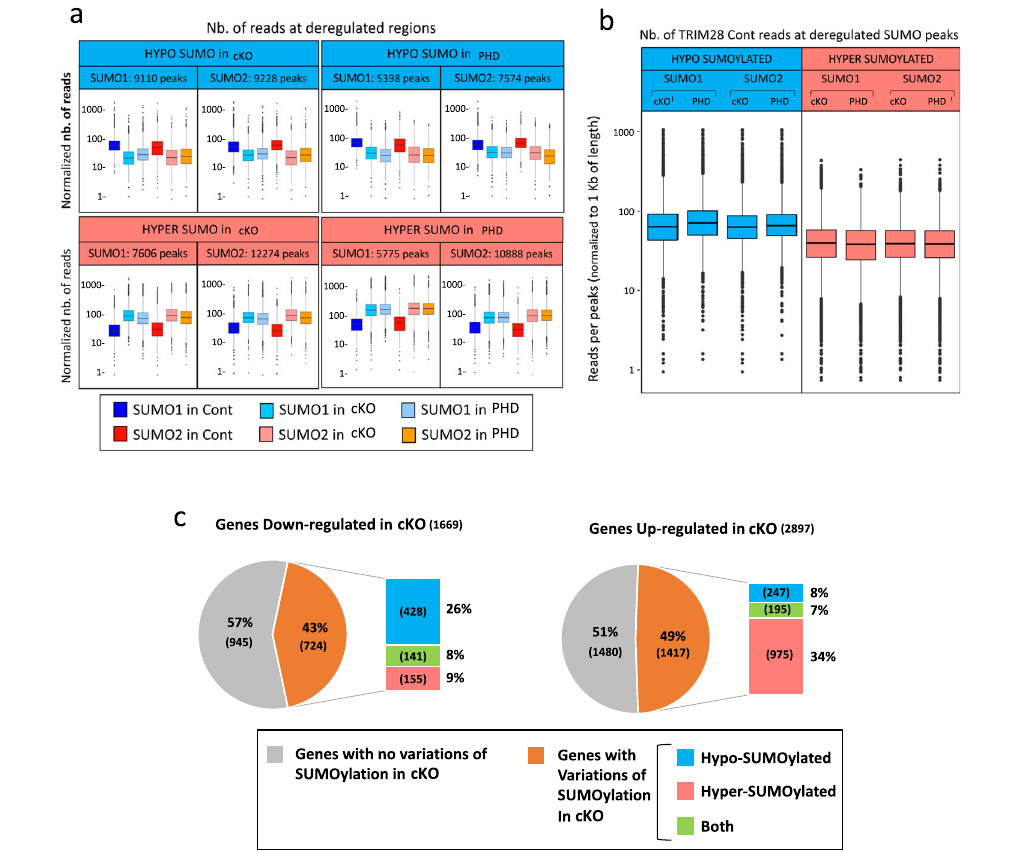
Fig. 5 | Genome-wide SUMOylation changes in Trim28 cKO and Trim28 Phd/cKO ovaries. a Normalised quanti fi cation of SUMO1 and SUMO2 ChIP-seq reads from control (Cont), Trim28 cKO (cKO) and Trim28 Phd/cKO (PHD) ovaries mapped on deregulated regions: peaks signi fi cantly decreased (Log2 Fold-Change <1; hypo- SUMOylated; blue), and increased (Log2 Fold-Change >1; hyper-SUMOylated; red) in Trim28 cKO and Trim28 Phd/cKO ovariescomparedwithcontrols.Thenumberofpeaks analysed for each condition is reported on upper (blue or light red) of each chart. b Normalisedquanti fi cationofTRIM28ChIP-seqreadsfromcontrol(±1kbfromthe centre) at SUMO1 and SUMO2 hypo-SUMOylated peaks (blue box plots) and SUMO1 and 2 hyper-SUMOylated peaks (red box plots). cKO: Trim28 cKO . PHD: Trim28 Phd/cKO .Forboxplots,thecentrelinecorrespondstothemedian.Thenumber